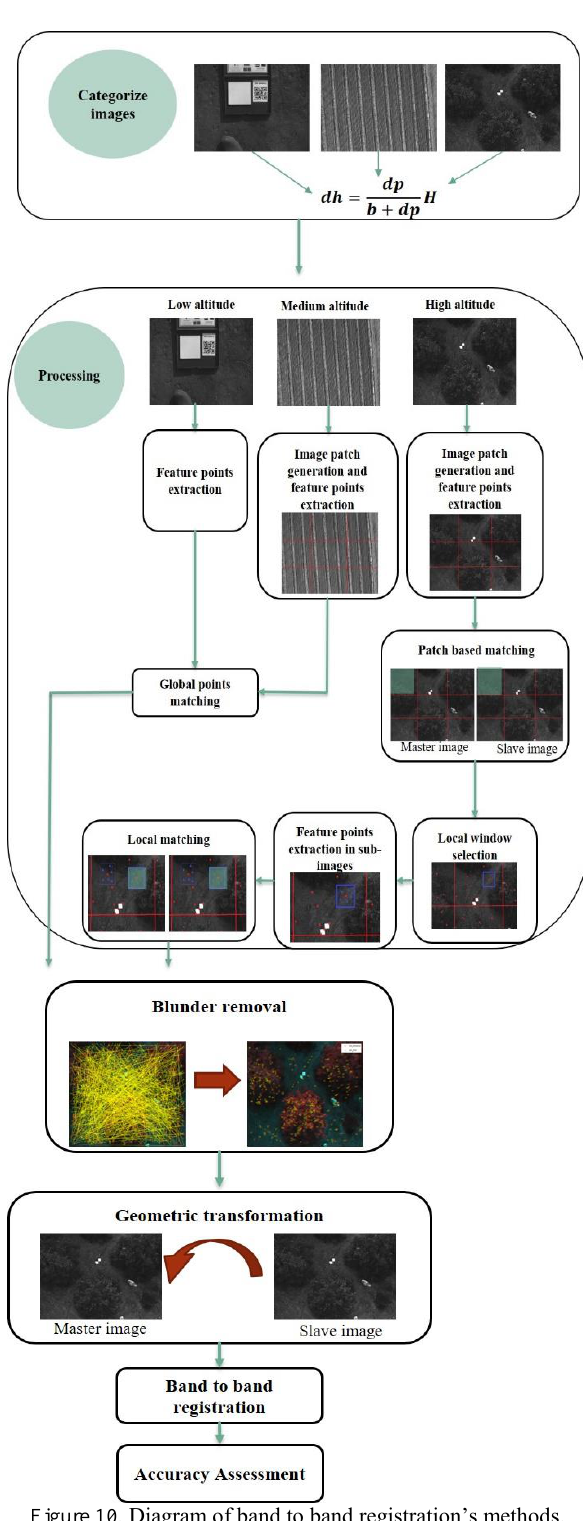
Figure 10. Diagram of band to band registration’s